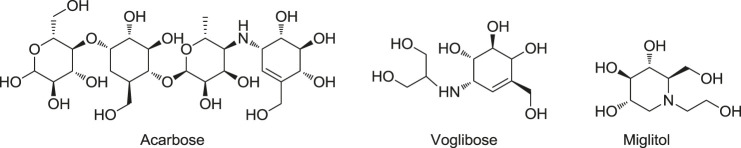
Clinically Approved α-glucosidase inhibitors.